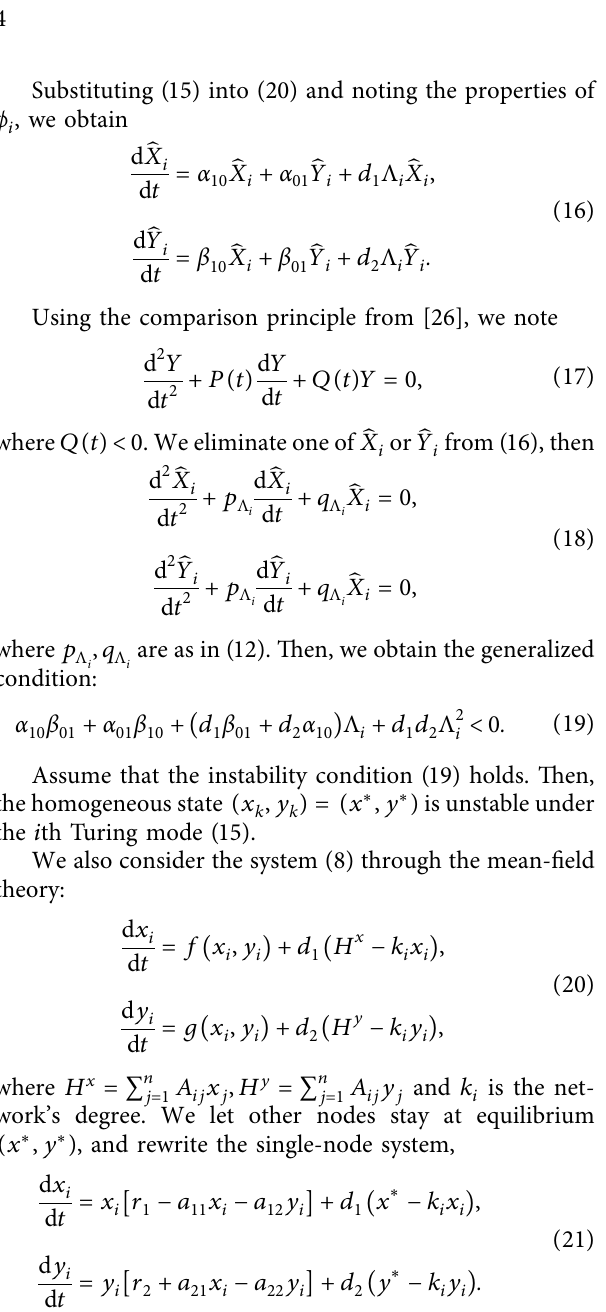
Figure 3: Turing bifurcation about d